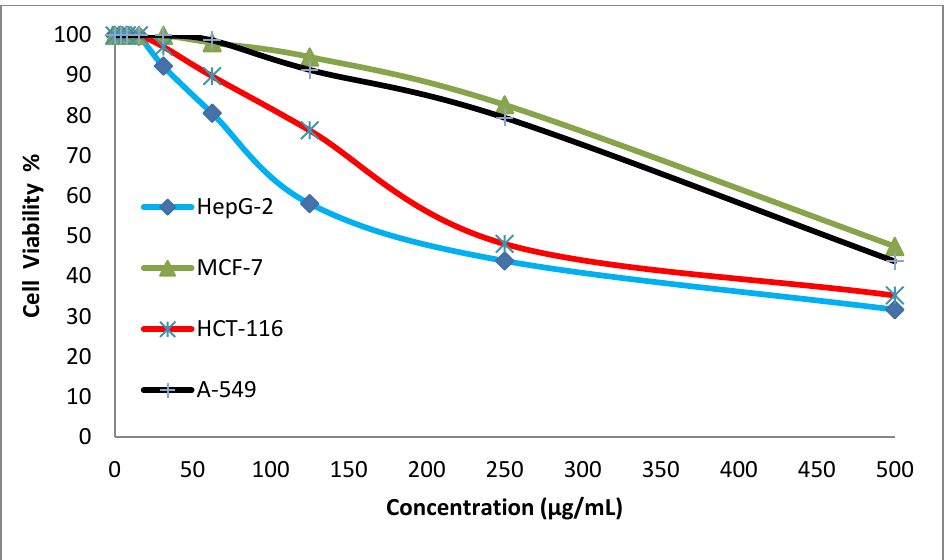
Figure 3. Evaluation of the cytotoxic effects of disperse dye 2.